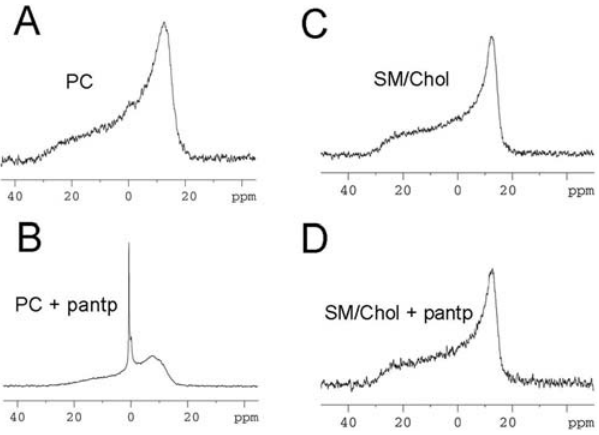
Figure 5. Effect of Penetratin in curvature of multilamellar vesicles. 31 P-NMRspectra ofMLV ofdifferent compositionin the absence (A,C) and the presence of Penetratin (B,D) at a Peptide/Lipid weight ratio of 1/7. Typical spectra of lamellar phases are observed for both PC and SM/Chol (1/1) preparations in the absence of peptide. In the presence of Penetratin, an isotropic signal was observed for PC membranes consistent with the presence of highly curved membranes (B). Penetratin showed no effect on the liquid ordered (raft-like) membrane (D).